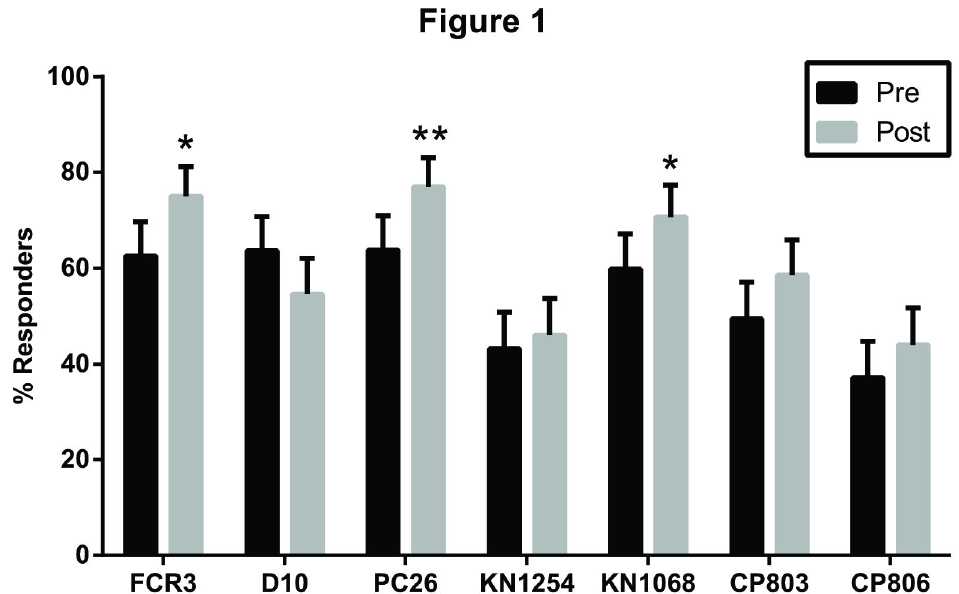
Figure 1. Comparison of % responders before and after the 2009 transmission season. The proportion of iRBCs recognized by IgG (% recognition) was measured by flow cytometry before and after the 2009 transmission season in all 176 children. A child with a % recognition value greater than the mean + 2 standard deviations of the % recognition value in American adults was defined as a “responder.” The % responders to each parasite strain before and after the transmission season was compared using Fisher’s exact test. *p<0.05, **p<0.001. Error bars shown are the upper 95% Confidence Interval for the % responder estimates. doi: